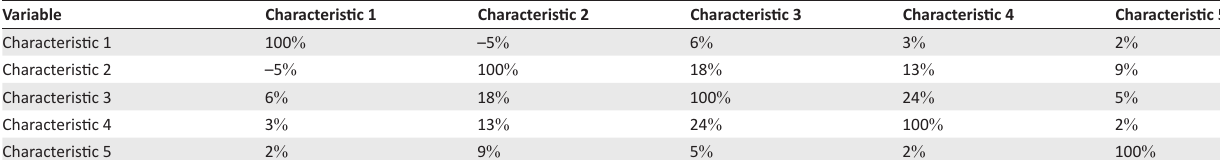
FIGURE 7: Score trend (internal application scorecard). TABLE 8: Correlation (out-of-time).